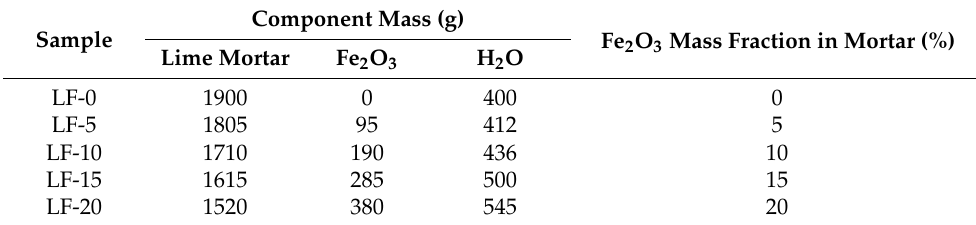
Table 2. Samples and compositions.